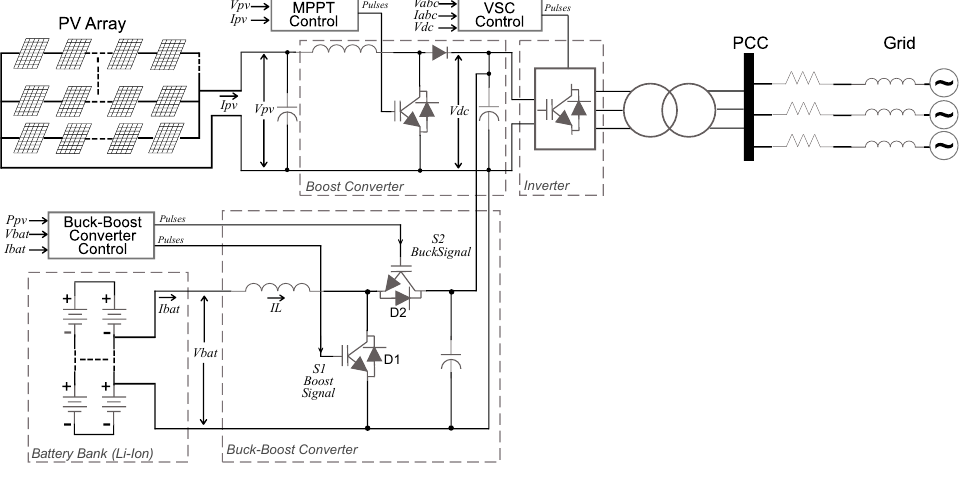
Figure 5. BESS-equipped PV solar plant diagram.